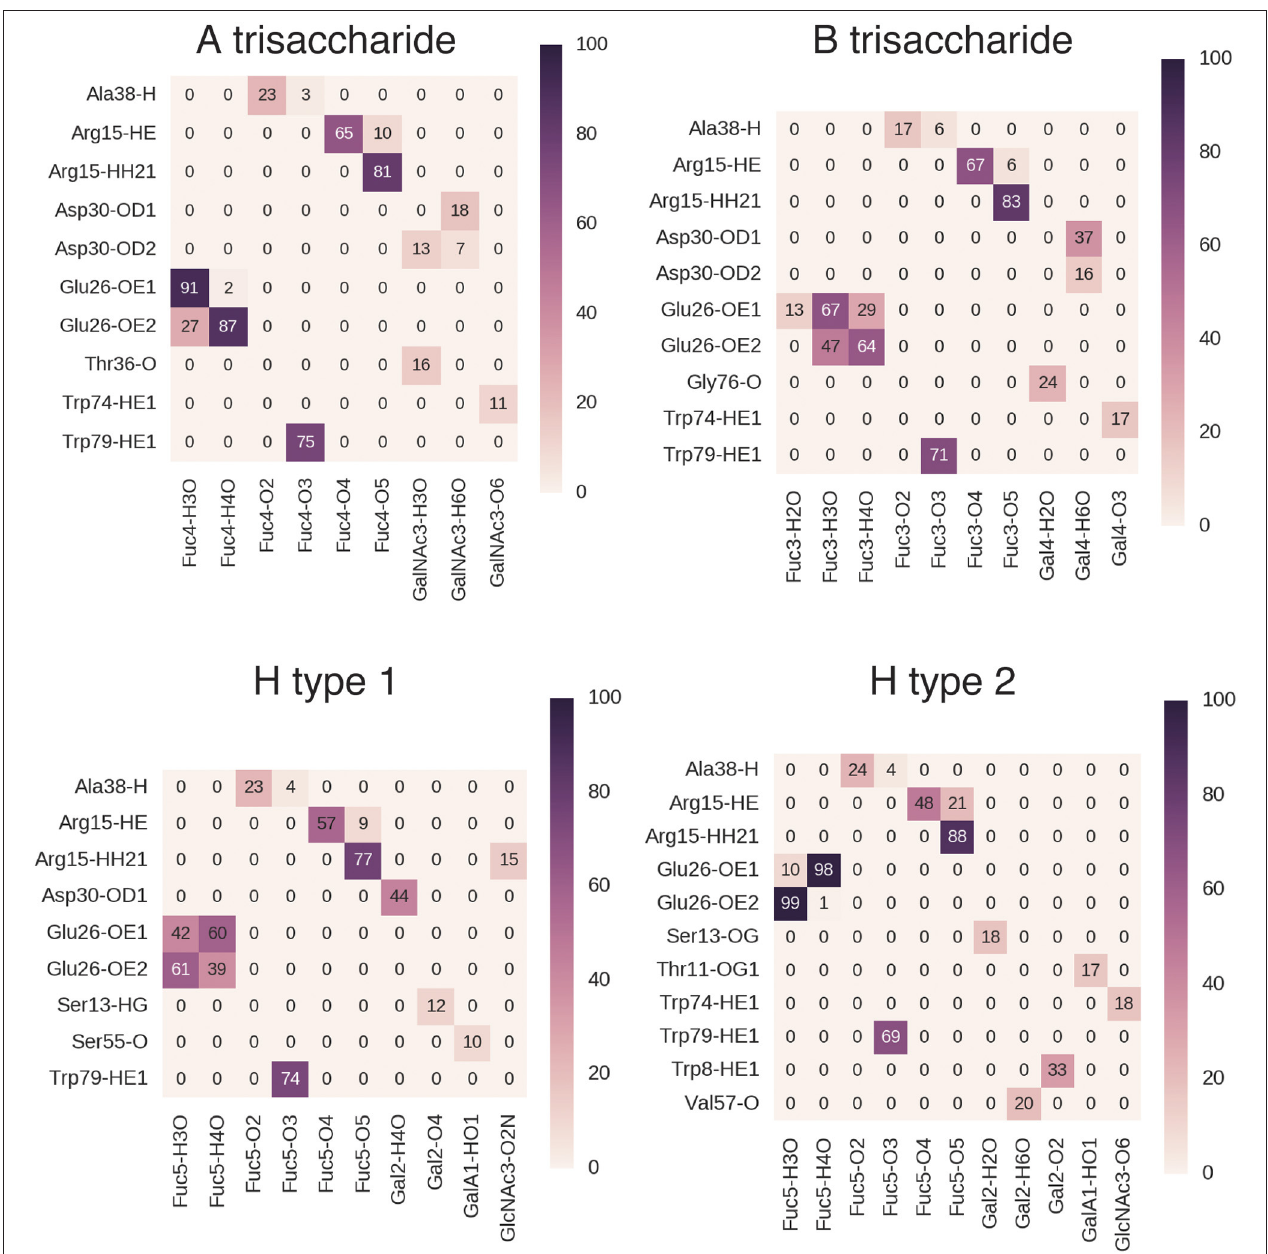
FIGURE 5 | Hydrogen bond interactions in BambL-saccharide complexes during MD simulations shown for A trisaccharide, B trisaccharide, H type 1 and H type 2 blood groups. Atoms are named to the conventions of the PDB exchange dictionary. Grid cells are colored and labeled by average occupancy from three replicate simulations. Occupancy values were calculated by dividing the number of frames in which the hydrogen bond exists by the total number of simulation frames.